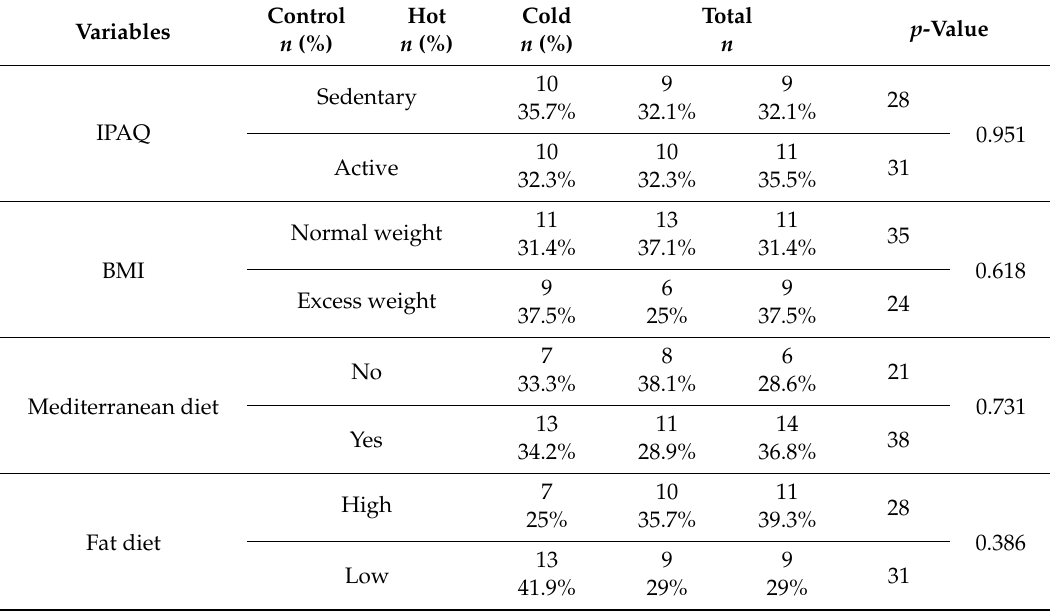
Table 1. Description of the study